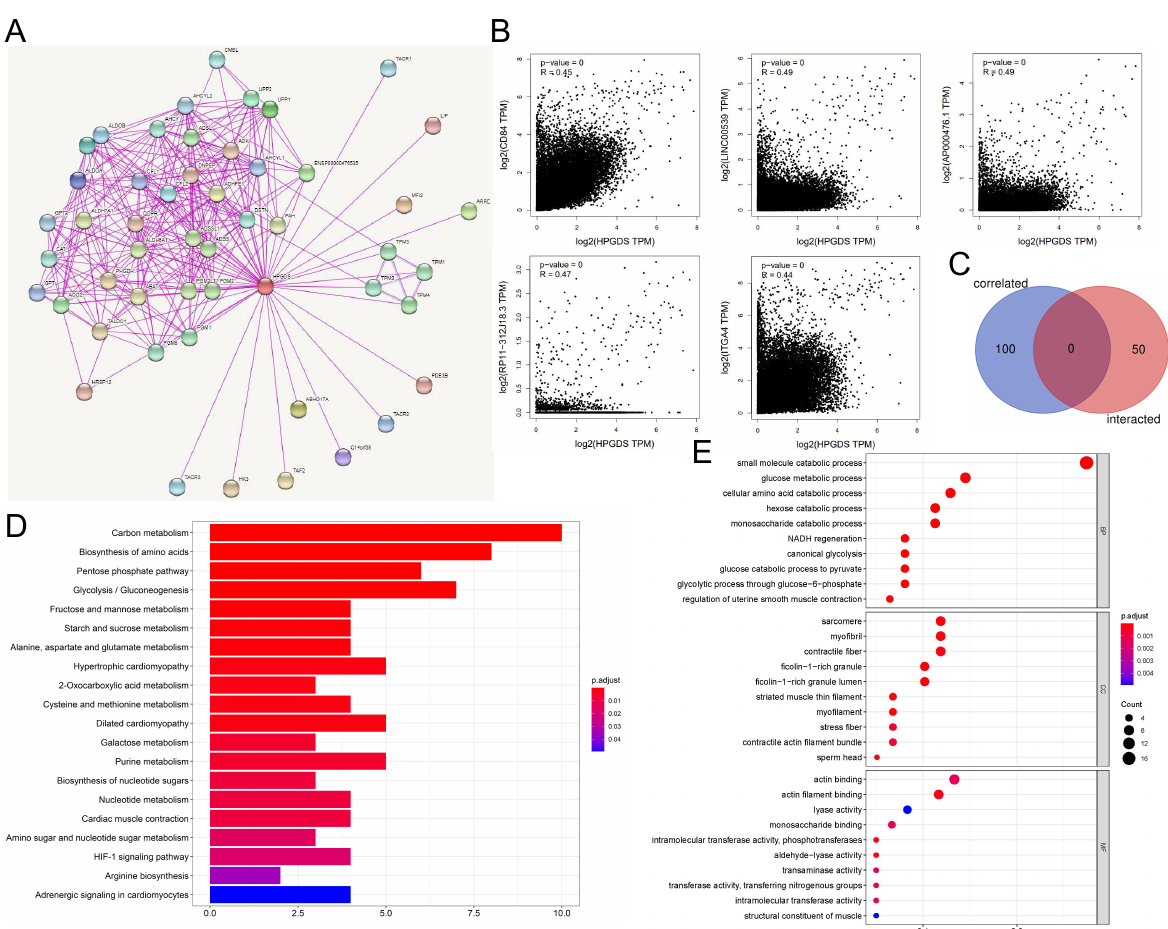
Figure 5. Effects of microwave pretreatment on the composition and content of phytosterols in Figure 5. HPGDS-related gene enrichment analysis. ( A ) Experimentally determined HPGDS-binding rapeseed. Values are the means standard deviations; n = 3 parallel determinations. a–d Mean proteins were identified using STRING. ( B ) The correlations of the expression of HPGDS and the ± values (a > b > c > d, corresponding to the same parameter) not followed by a common letter differ five most related genes in cancers are shown. ( C ) An analysis of the intersections of genes encoding significantly ( p < 0.05). HPGDS-binding proteins and expression-correlated genes was conducted. ( D ) KEGG pathway analyses were performed on the genes encoding HPGDS-binding proteins and expression-correlated genes. ( E ) GO analyses were also